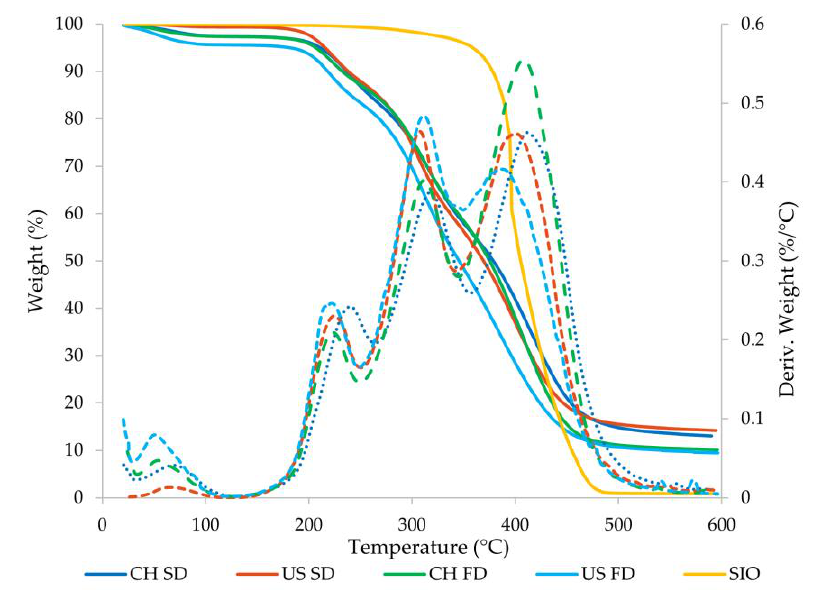
Figure 2. TGA of sacha inchi seed oil microcapsules prepared with CH and US and dried by SD and FD. ( — ) Weight loss. (---) Derived from weight